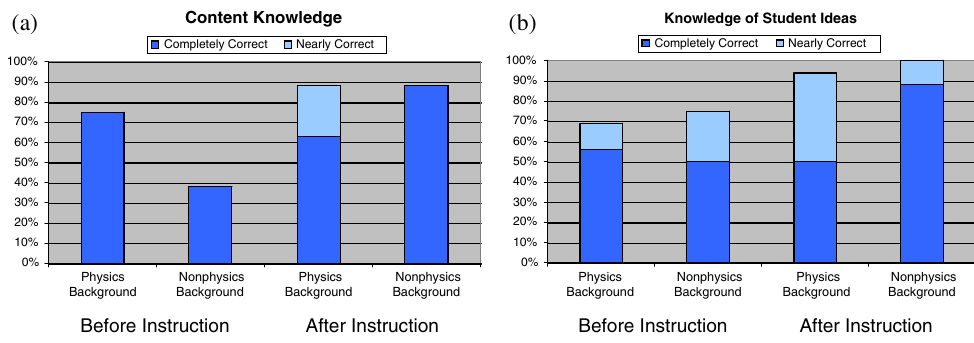
FIG. 8 (color online). Preinstruction and postinstruction results for multiple semesters of the class ( N ¼ 24 ; N physics ¼ 16 ; ¼ 8 ) on (a) content knowledge and (b) pedagogical content knowledge for the electric circuits unit. ‘‘Nearly correct’’ N nonphysics responses are those that contain one minor error over several questions (CK) or explanations that were somewhat vague (PCK), but still technically correct.